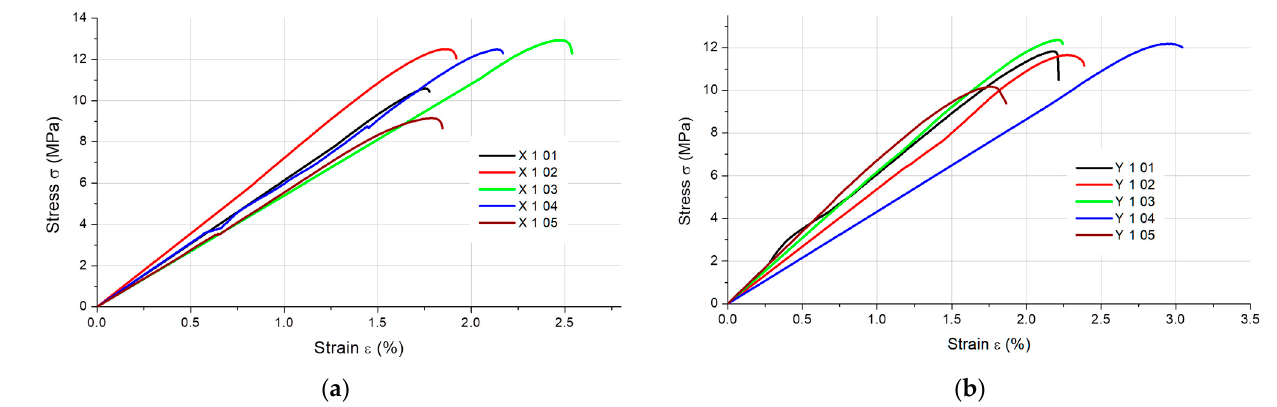
Figure 2. Stress–strain curves for the 1 mm thick specimens composed of PLA + bronze printed in